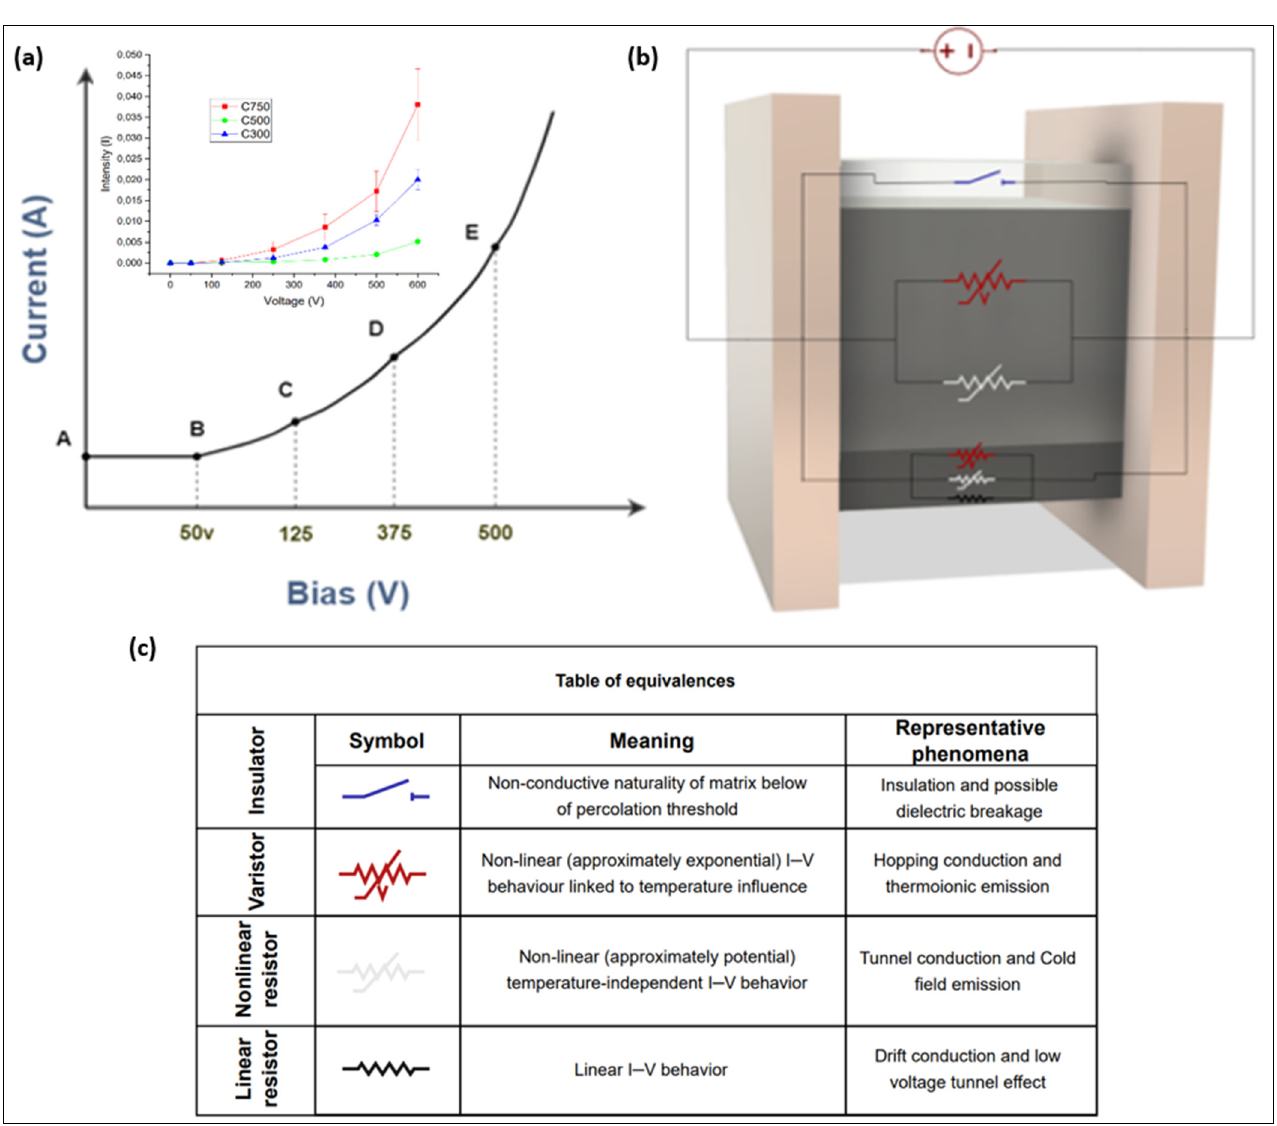
Figure 12. General I–V tendency graph ( a ), general equivalent circuit scheme ( b ), and table of equivalences for the equivalent electric elements representative conductive phenomena ( c ).